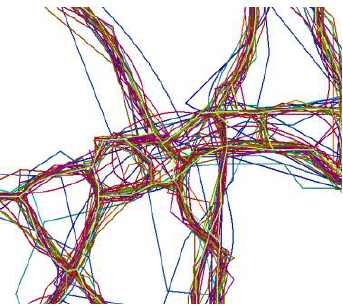
Figure 1. Example of multiple collected road network data